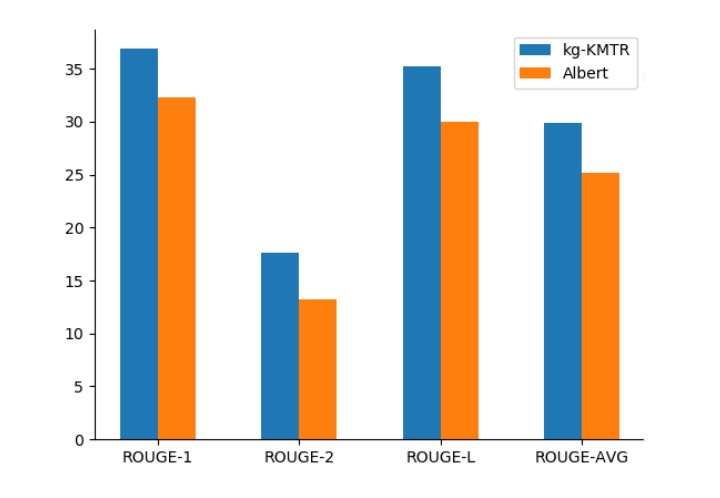
Figure 5. Performance comparison of kg-KMTR and